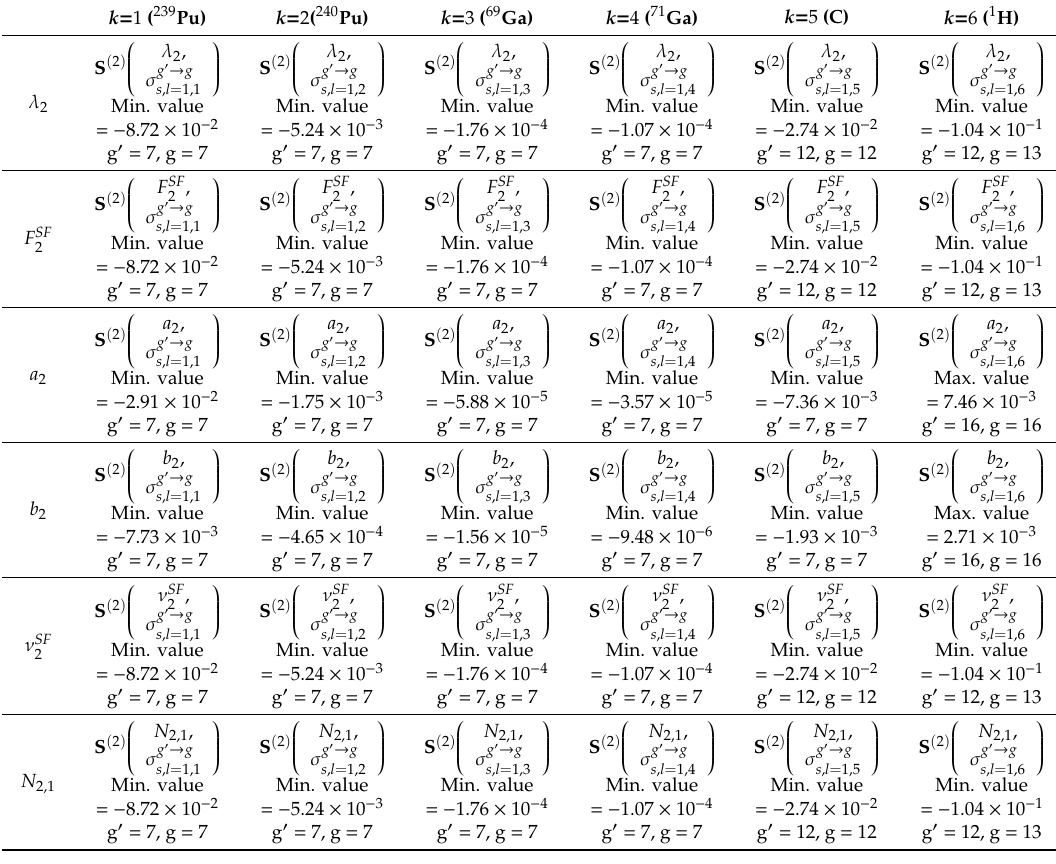
(cid:16) (cid:17) (cid:48) → g q j , σ g , for 2nd-order relative sensitivities of s , l = 1, k